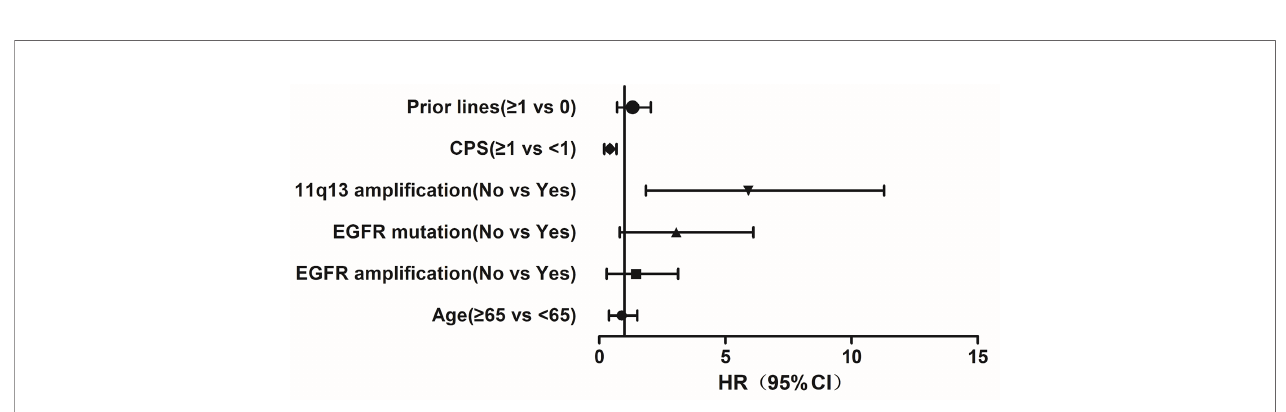
FIGURE 2 | Multivariate analyses of treatment lines, CPS level, 11q13 ampli fi cation, EGFR mutation, EGFR ampli fi cation, and age with progression-free survival. CPS and 11q13 ampli fi cation are independent factor affecting progression-free survival.